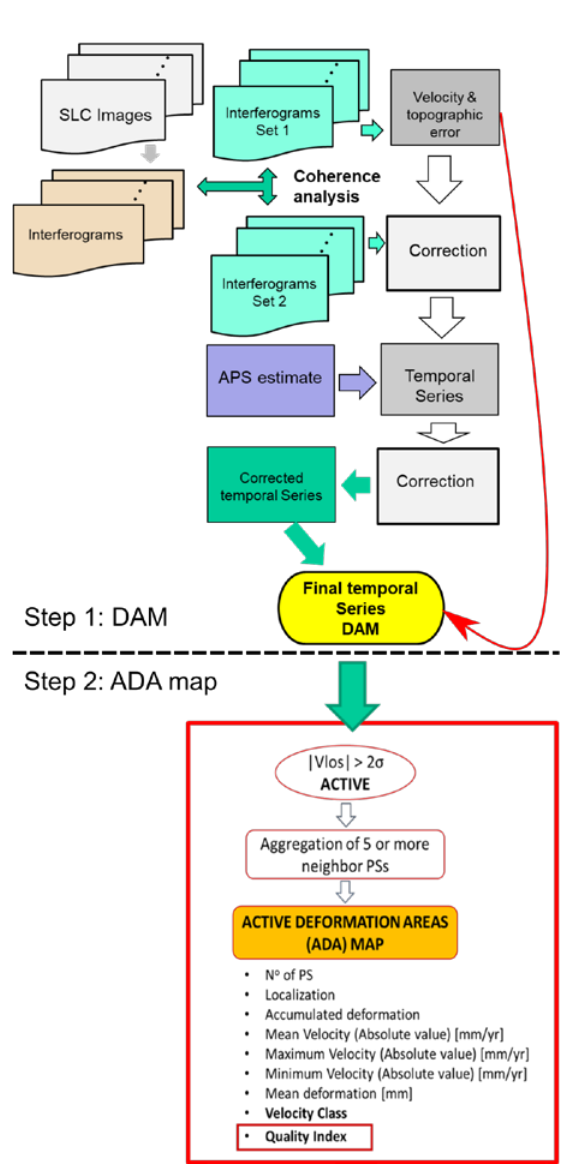
Figure 6: Workflow of the developed methodology. to produce DAM and ADA. The main products of the methodology are highlighted in